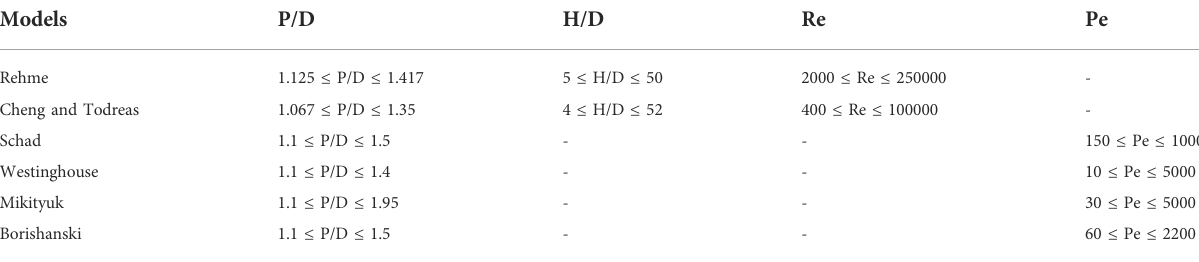
TABLE 6 Applicable range of models. Models